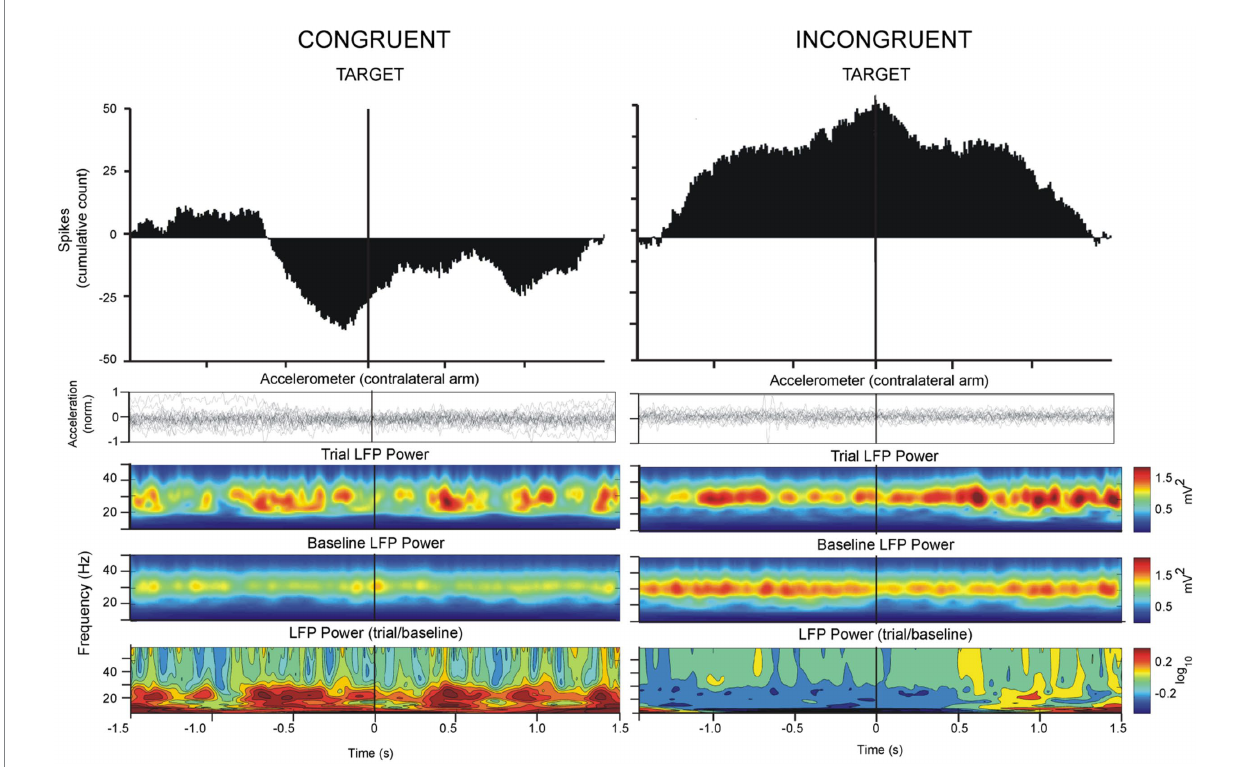
FIGURE 4 Analysis of LFP oscillations and spiking activity as in Figure 3, referenced to the TARGET trigger in congruent and incongruent paradigms. Vim neuronal firing decreased prior to TARGET approach in the congruent orientation. In the incongruent orientation, Vim firing increased on approach to TARGET concomitantly with a decrease in beta